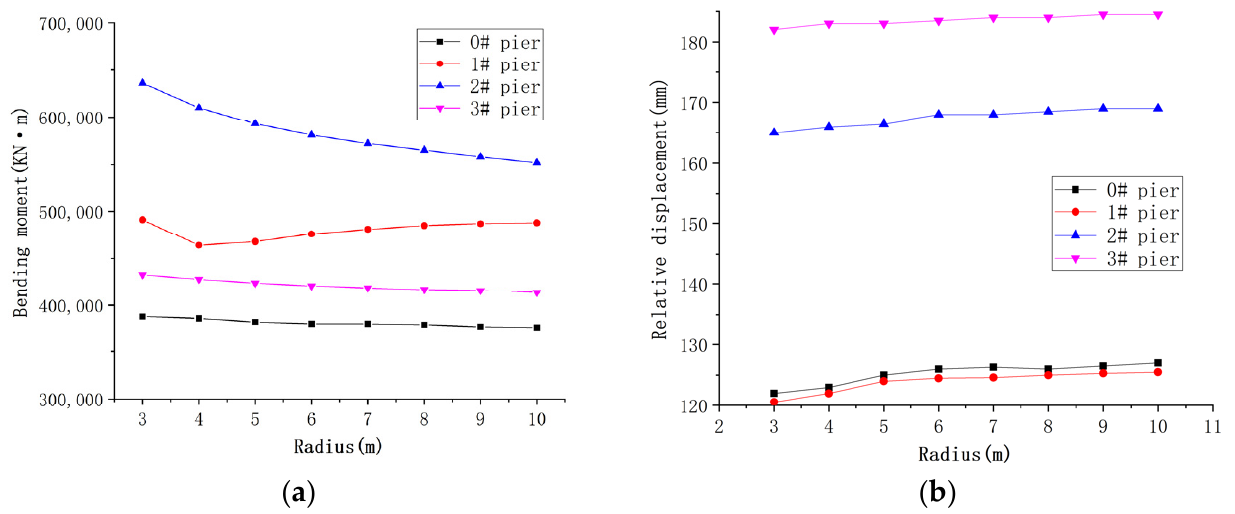
Figure 10. Seismic response of the longitudinal bridge direction (radius of curvature, R). ( a ) Bending moment at the bottom of pier ( b ) Relative displacement between piers and beams.